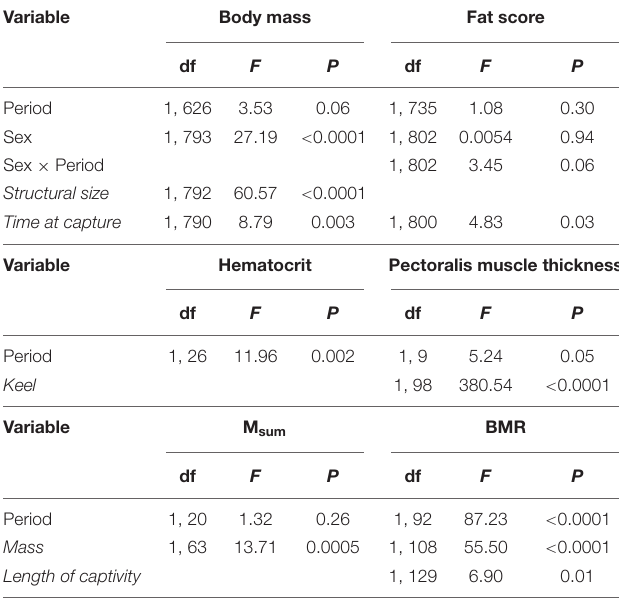
TABLE 3 | Linear mixed-effects models comparing phenotypic traits in snow buntings measured during wintering at Rimouski and during pre-breeding at